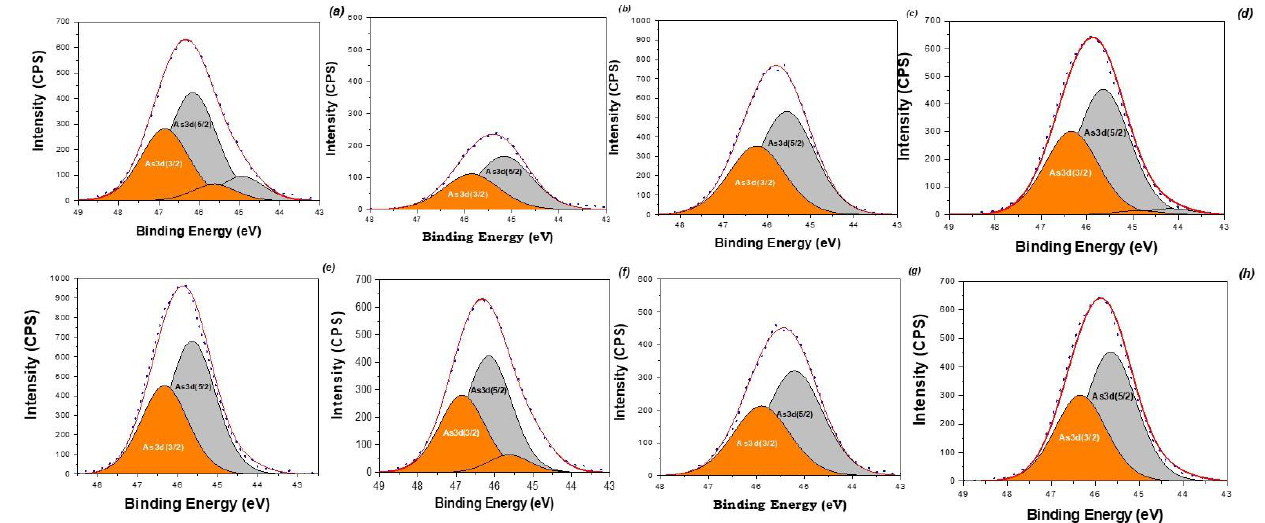
Figure 12. XPS patterns of As 3d binding energy of the MNPs (MNP-1 ( a ), MNP-2 ( b ), MNP-3 ( c ), MNP-4 ( d ), MNP-5 ( e ), MNP-6 ( f ), MNP-7 ( g ) and MNP-8 ( h )) saturated with As(V) at 25 °C.